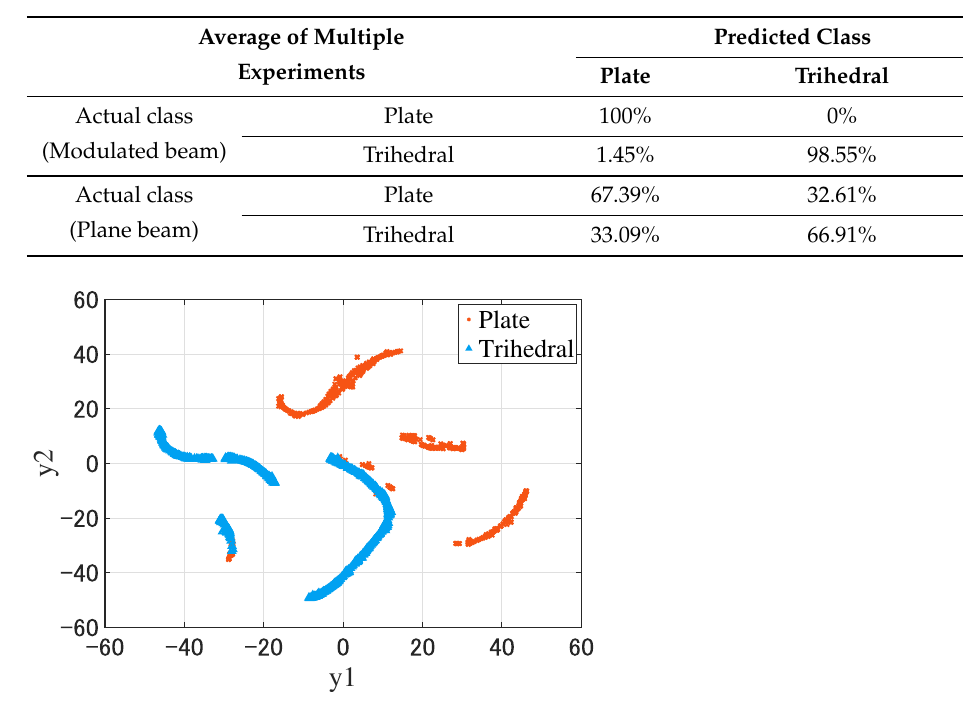
Table 5. The classification rate of the modulated beam and plane beam.